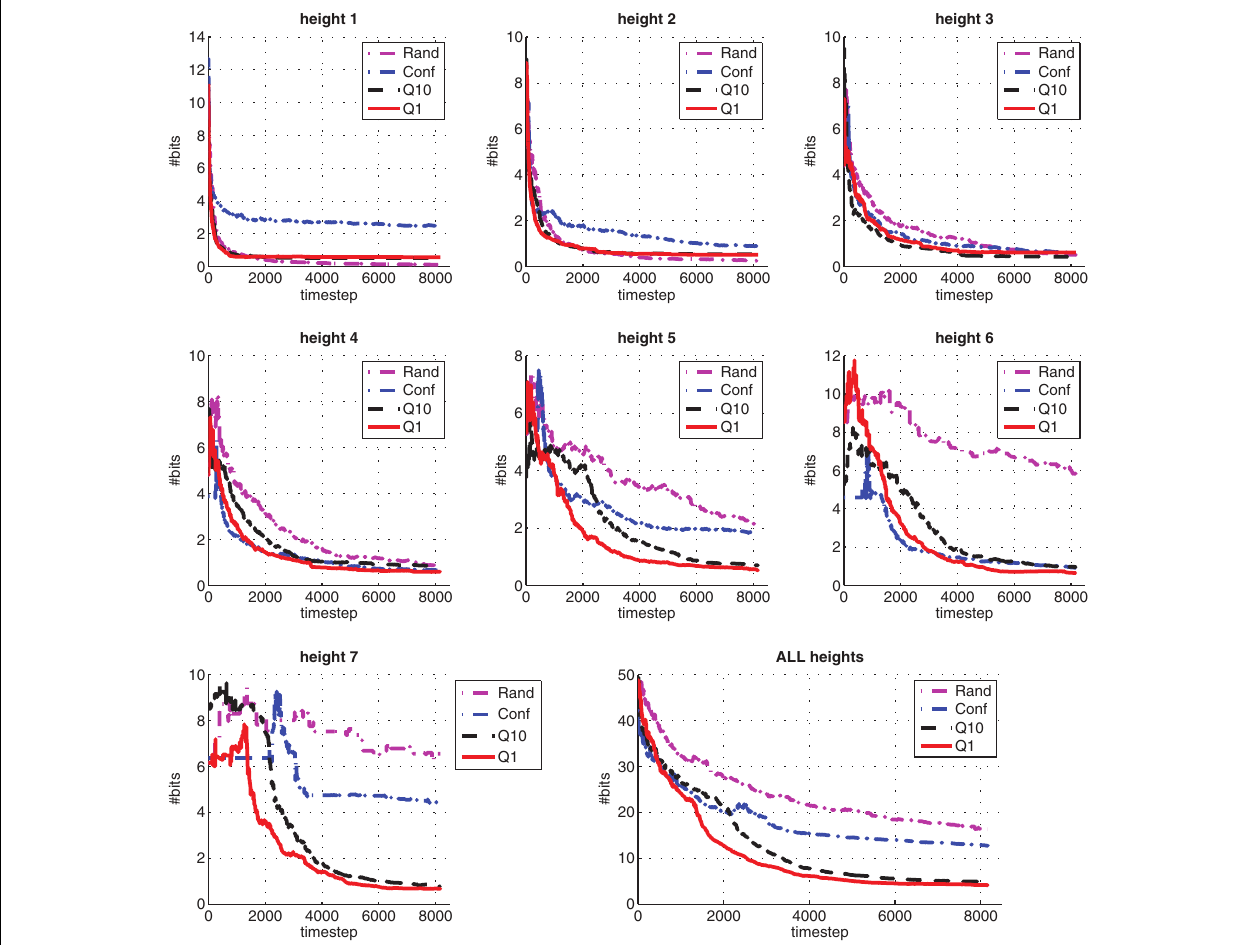
FIGURE 9 | A comparison of exploration methods in terms of the KL-divergence between the learned predictive models at each time step and their ground-truth models. Results are averaged over 10